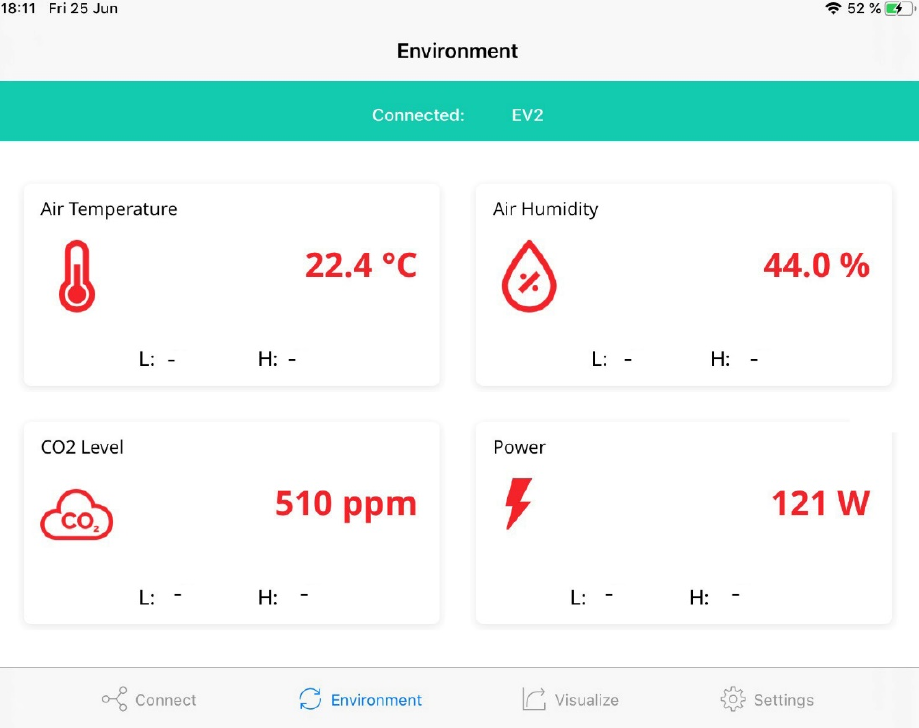
Figure 33. The iPhone/iPad application.